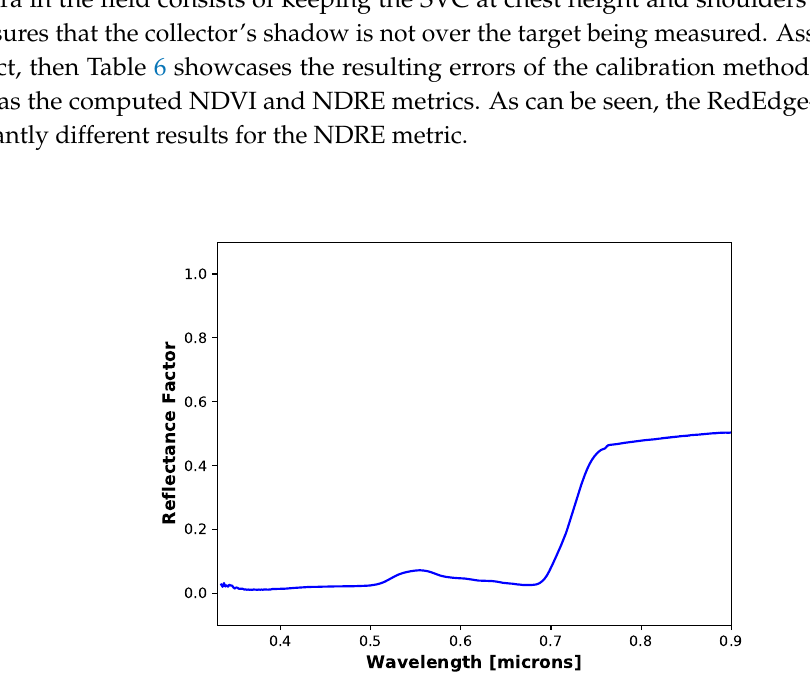
Figure 24. Ground reference reflectance of grass target measured with SVC during a field collection in 2018. This measurement is a single measurement of the grass target. Table 6. Grass target reflectance factor errors as a result of calibration